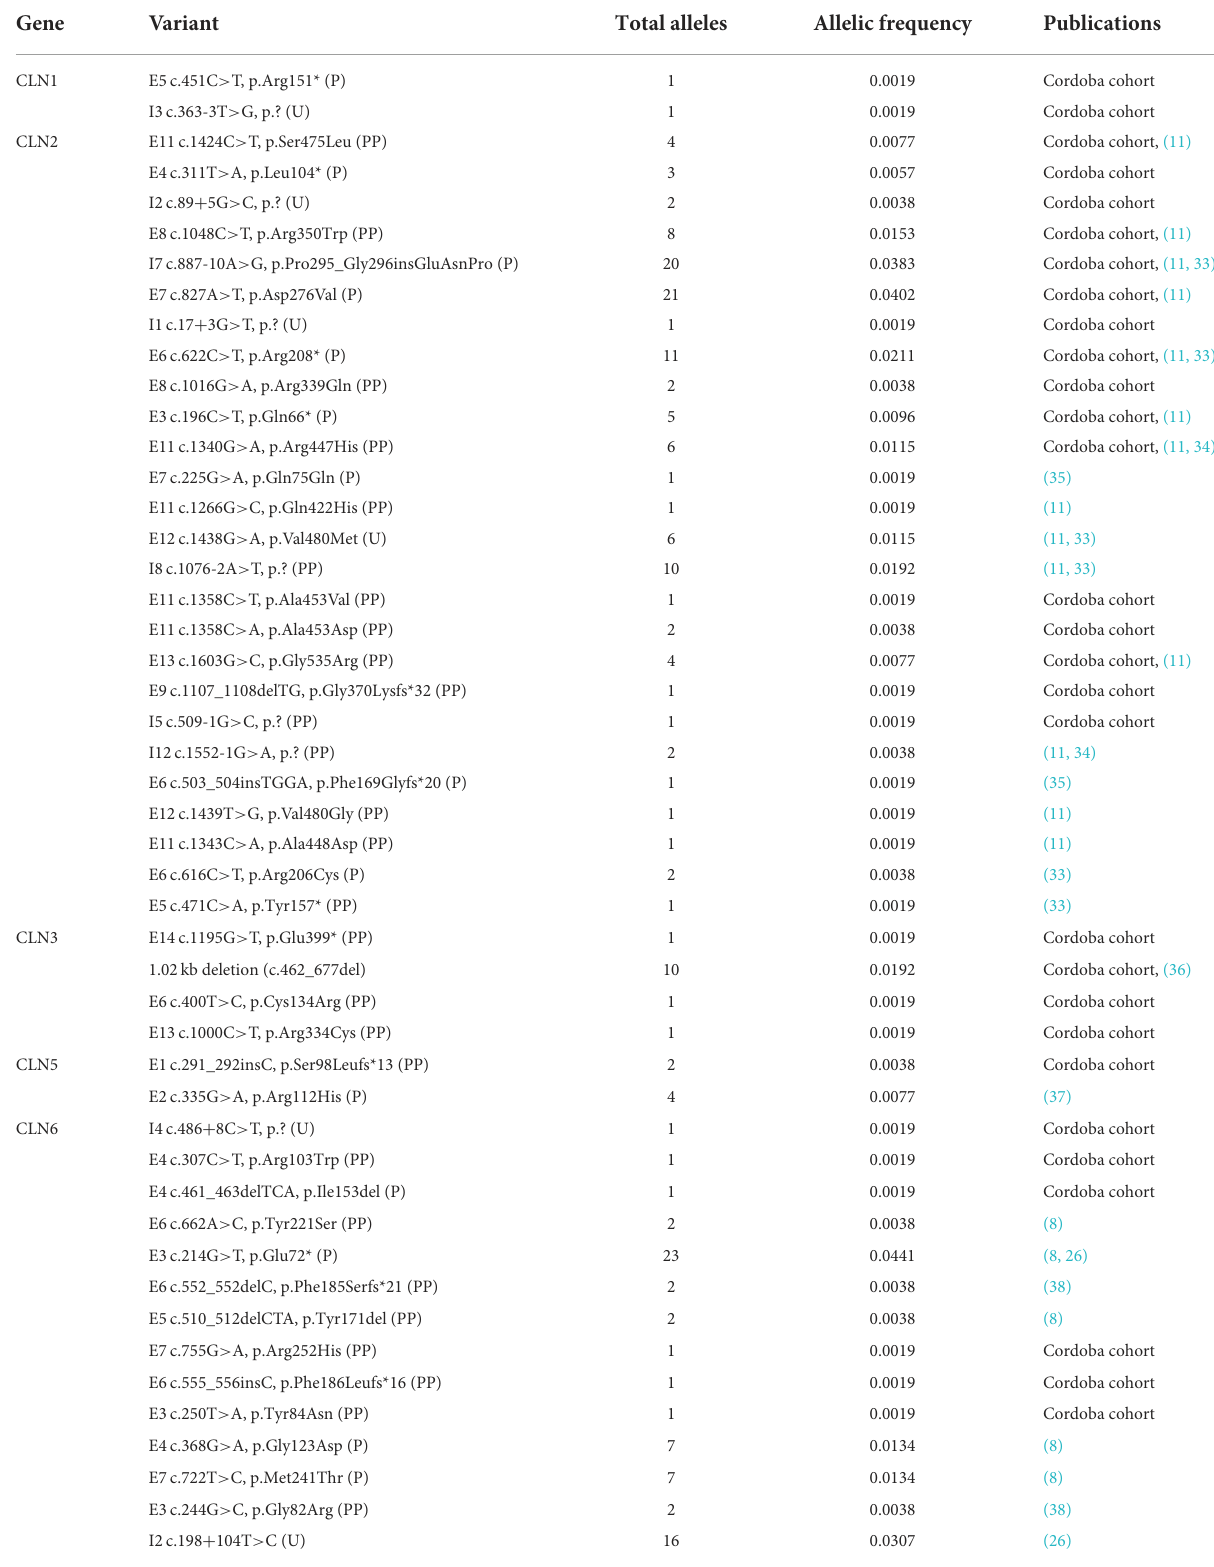
TABLE 1 List of DNA variants described in the SA & C